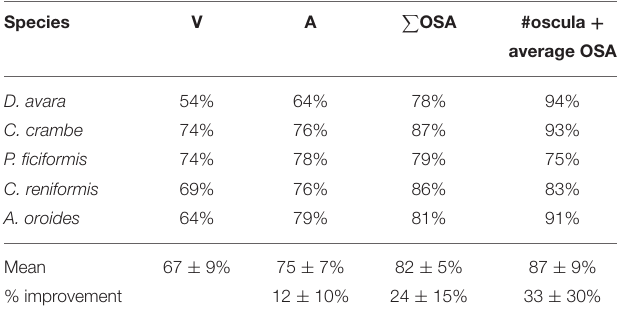
24 ± 15% 33 ± 30% Table data are the percentage of explained variance gained using different predictor variables for the sponge pumping rate (PR, mL min − 1 sponge − 1 ). These values were calculated as 100 × R 2 of each regression model. Each column represents different predictor parameter: V, sponge volume (cm 3 ); A, sponge area (cm 2 ); P OSA, total osculum cross-sectional area (mm 2 ), and the last column is the % variance explained by the multiple regression analysis using number of oscula (#oscula) and mean oscula size (average OSA) as predictor variables. Mean ( ± the 95% CI) is the average R 2 for all five species. % improvement was defined as the mean ( ± the 95% CI) increase of the percentage of variance (100 × R 2 ) explained using the different predictors and compared to the percentage of variance explained using V (sponge volume) as a